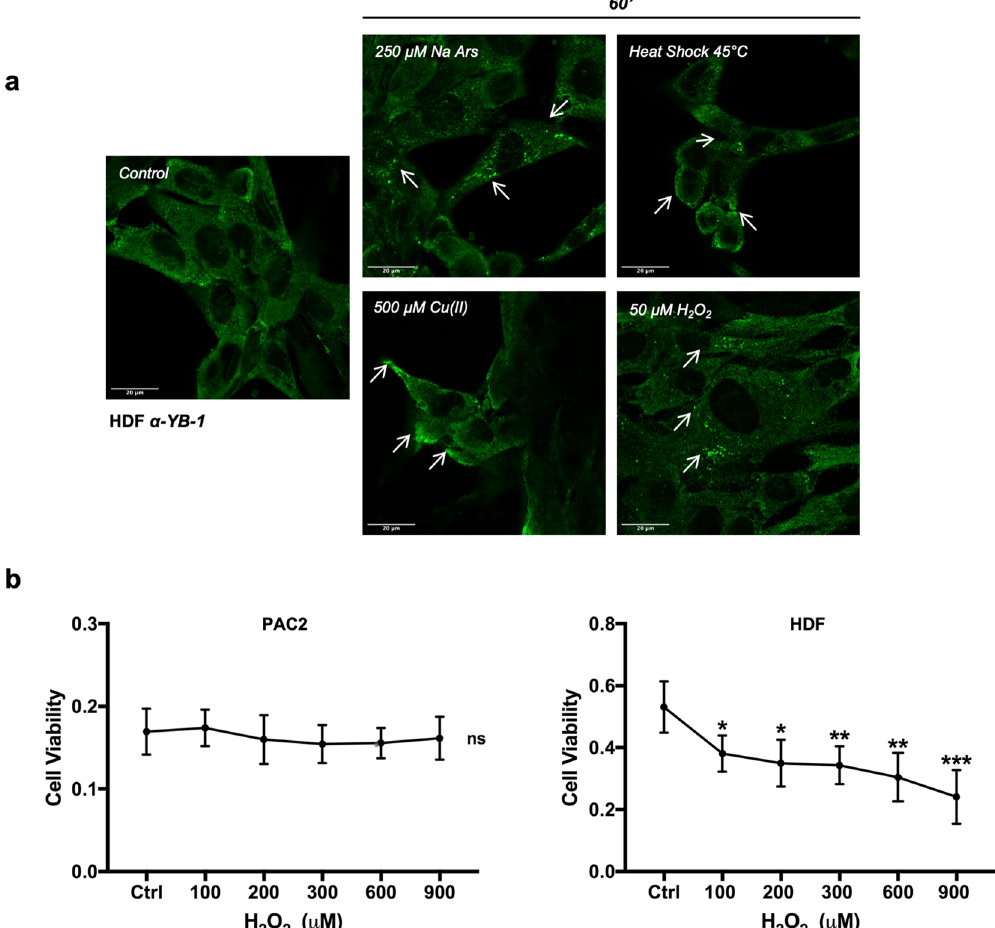
Figure 8. Heat shock, Arsenite, Copper and H 2 O 2 treatment promotes assembly of YB-1 positive aggregates in human HDF fibroblast cells. ( a) Representative confocal immunofluorescence images of HDF cells stained with human α -YB-1 C- ter antibody (green). Some YB-1 aggregates are indicated by arrows. ( b) Cell viability assay (MTT) in PAC2 and HDF cells after 45 minutes treatment with different doses of H 2 O 2 . Statistical analysis was performed using 1-way ANOVA followed by Tukey’s multiple comparisons test. Levels of significance are indicated ( *** p 0.001) (see also Table